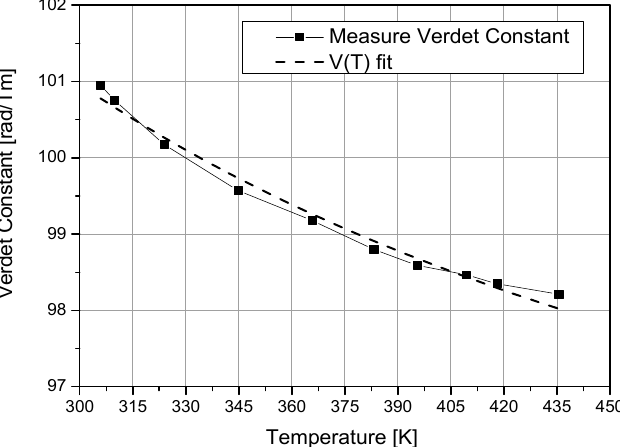
Figure 3. Measured temperature dependence of the Verdet constant of the Bi 12 GeO 20 crystal.